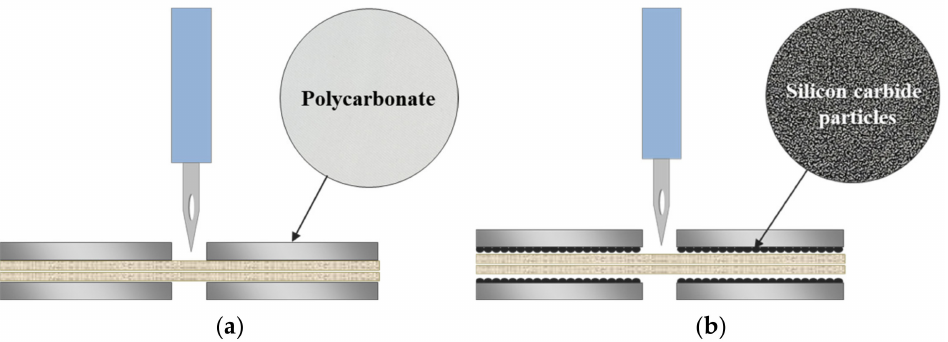
Figure 2. Diagram of the self-made template: ( a ) flat surface template; ( b ) rough surface